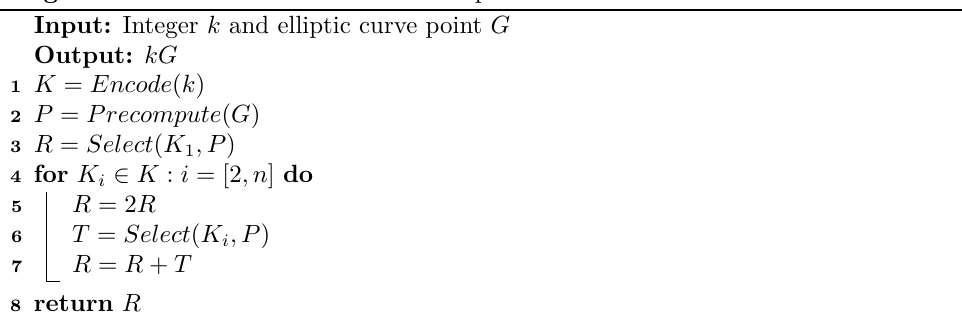
Algorithm 3: mbedTLS comb scalar multiplication